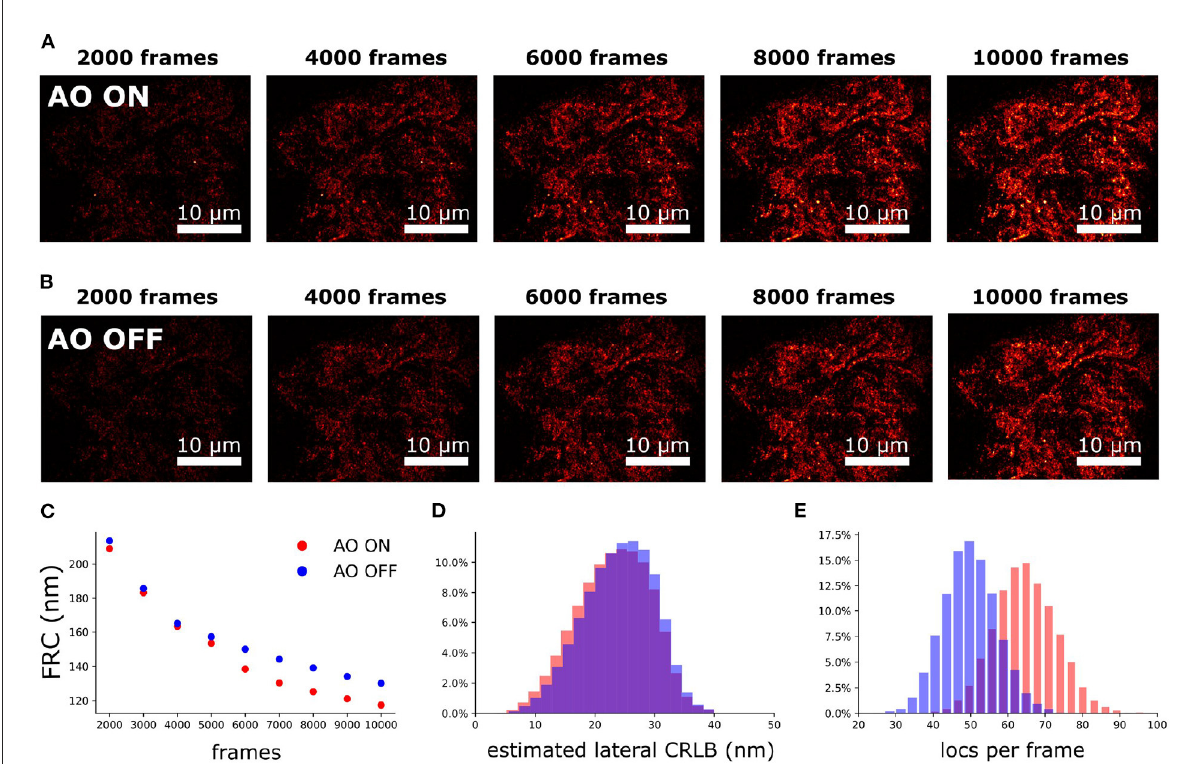
FIGURE11 Aberration correction on mitochondria of spheroid Caco2-BBE cells (depth is 17 µ m). (A) SMLM reconstruction with correction. (B) SMLM reconstruction without correction. (A,B) Were rendered with same contrast to visualize the localization density. (C) FRC of (A,B) vs. the frame number. (D) Lateral CRLB distribution from the data-set of (A,B) . (E) Number of detected localizations per frame from the dataset of (A,B)